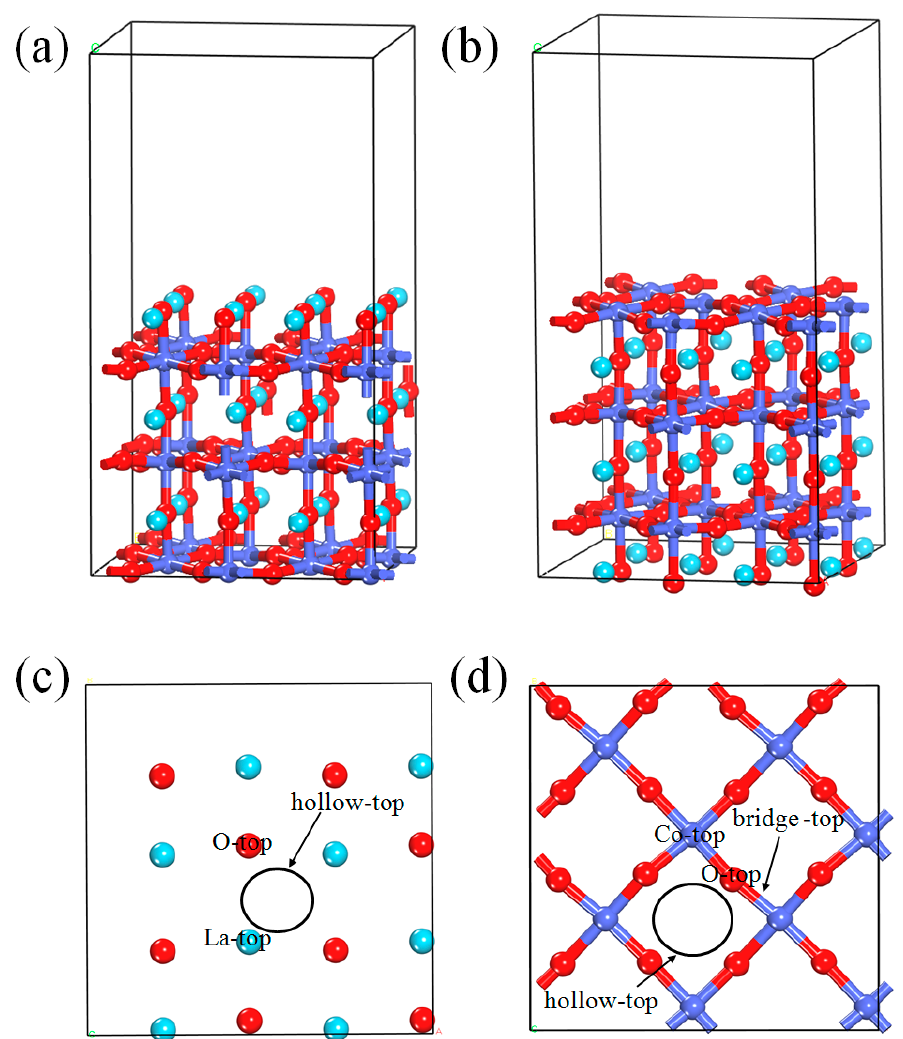
Figure 2. Side and top views of optimized LaCoO 3 (011) surface: ( a ) the side view of LaO-terminated surface, ( b ) the side view of CoO 2 -terminated surface, ( c ) the top view of exposed (011) LaO termination, and ( d ) the top view of exposed (011) CoO 2 termination.